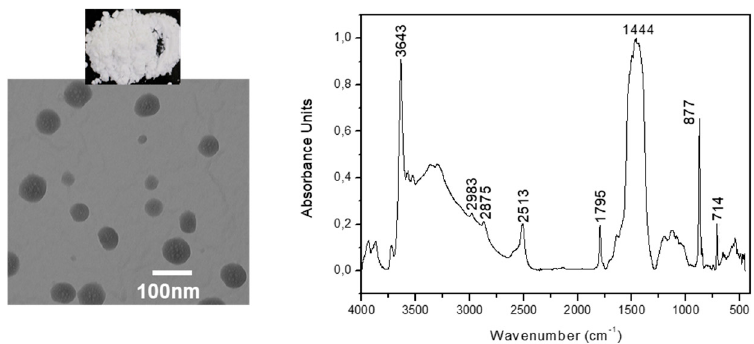
Figure 1. Photograph, TEM image, and FTIR spectrum of the produced nanoparticles.